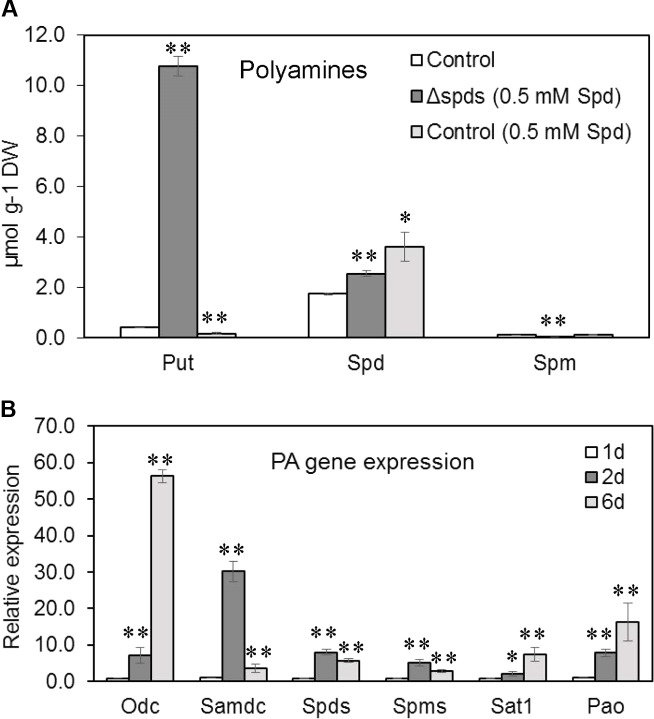
Polyamine contents and PA gene expression. (A) PA contents in the control (CA14 pyrG-1) and Δspds A. flavus CA14 strains grown in Czapek’s liquid medium (shake culture) with or without spermidine (Spd) for 8 days in the dark at 30°C; and (B) Developmental expression of PA genes (odc, samdc, spds, spms, sat1, pao) in A. flavus control strain (CA14 pyrG-1) grown in Czapek’s liquid medium (static culture) for 6 days in the dark at 30°C. Data are Mean ± SE of three replicates (∗∗P ≤ 0.05 and ∗P ≤ 0.10 between control and treatment or in comparison to day 1 in B, Student’s t-test).